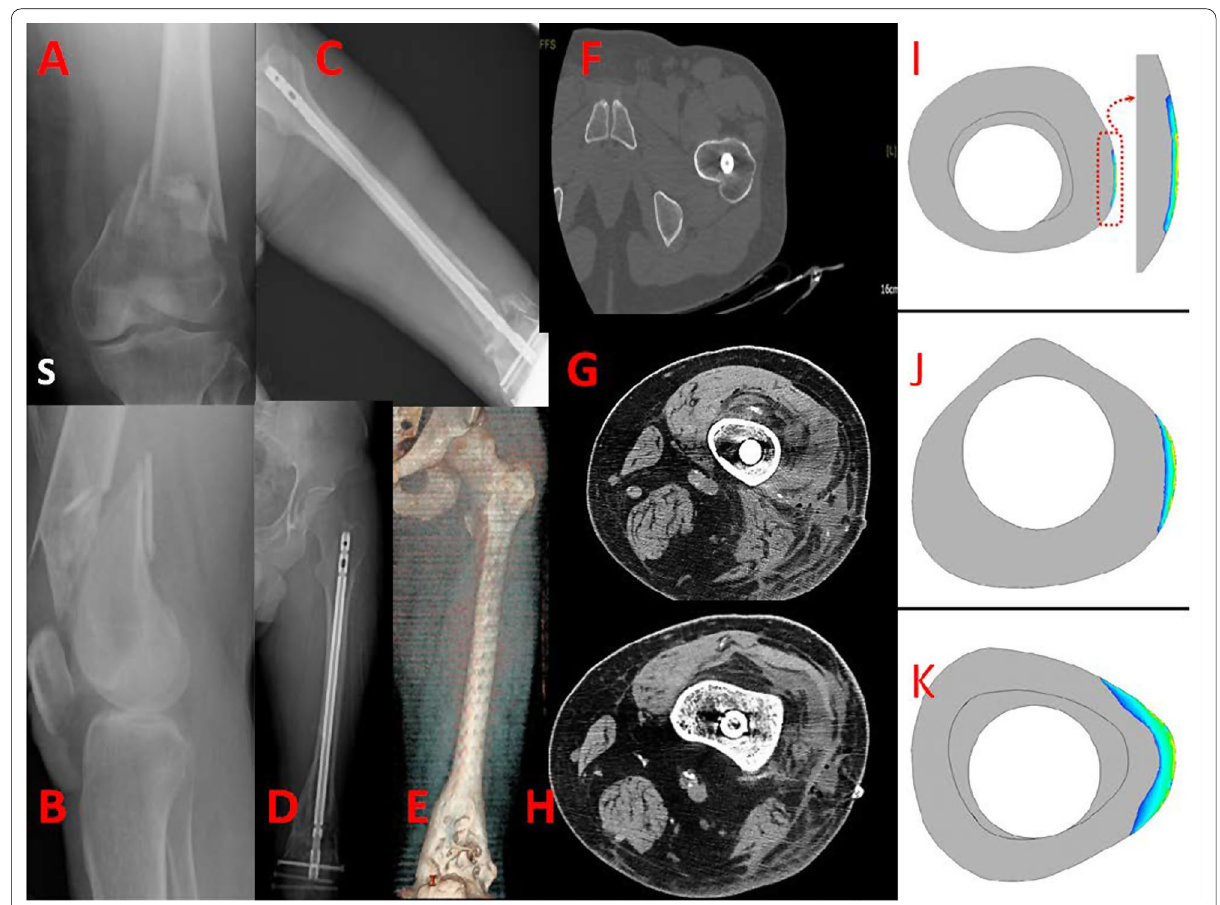
Fig. 3 35M, fall from height, 32 C3 type of fracture ( A , B ). Post-reduction X-ray with fixation with non-locking retrograde nail ( C ). X-ray and computed tomography (CT) scan at 12 months post-operation show satisfactory fracture healing ( D , E ). Absence of stress shielding of the nail is shown in F – H comparing images with biomechanics representations ( I – K ) proposed by Shih et